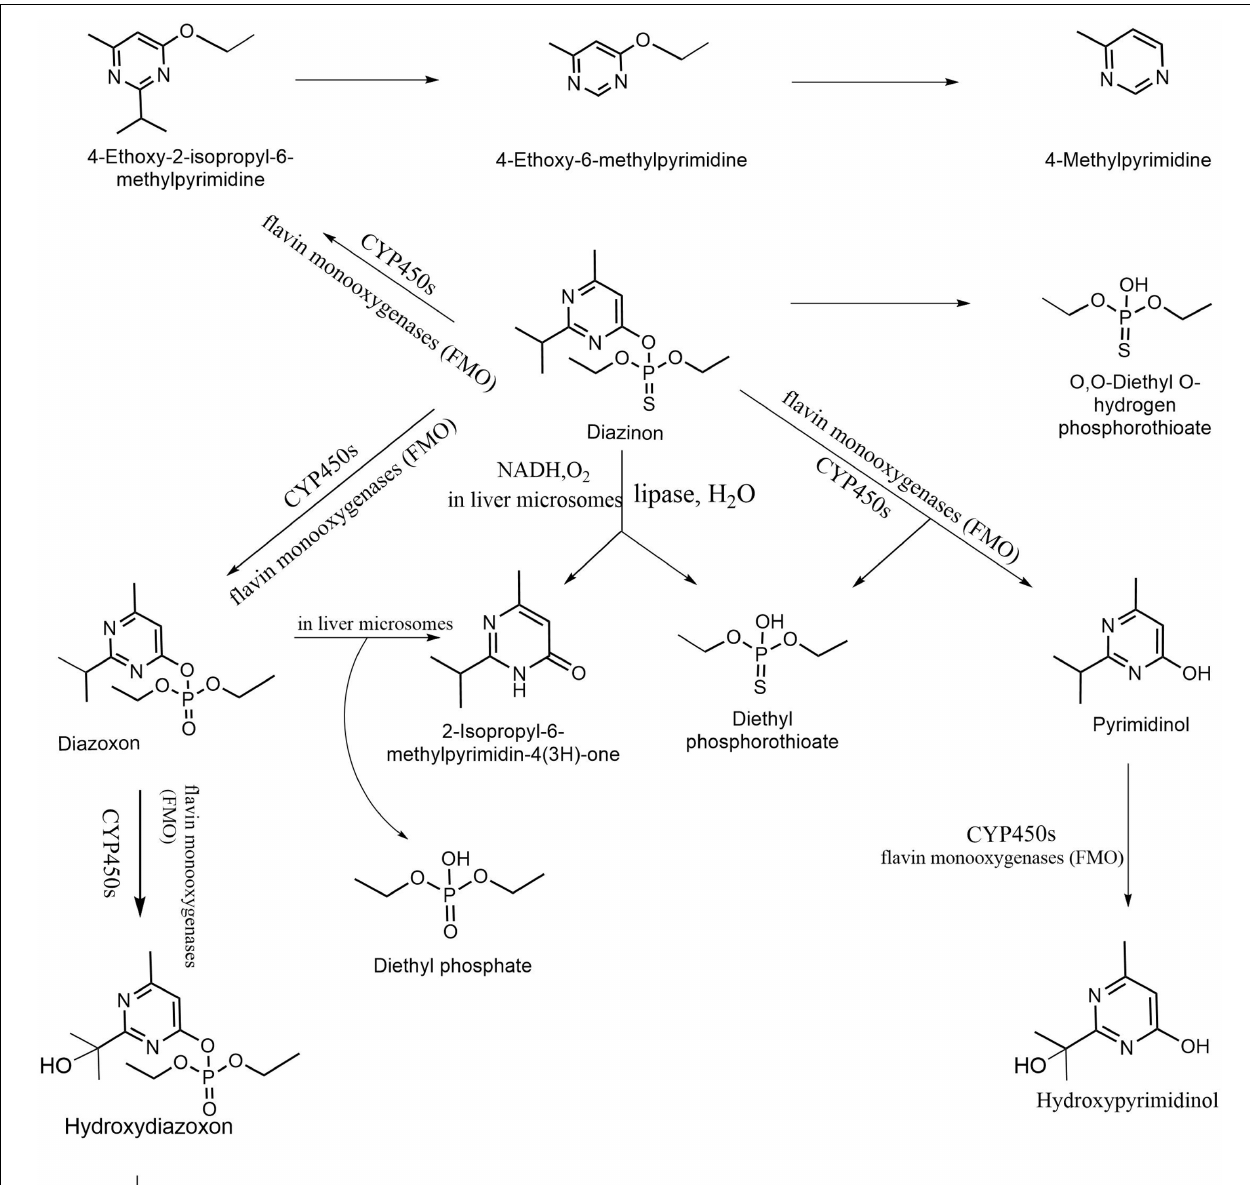
FIGURE 3 | Proposed microbial degradation pathways of diazinon in microorganisms (Wang and Liu, 2016; Zhao et al., 2020).